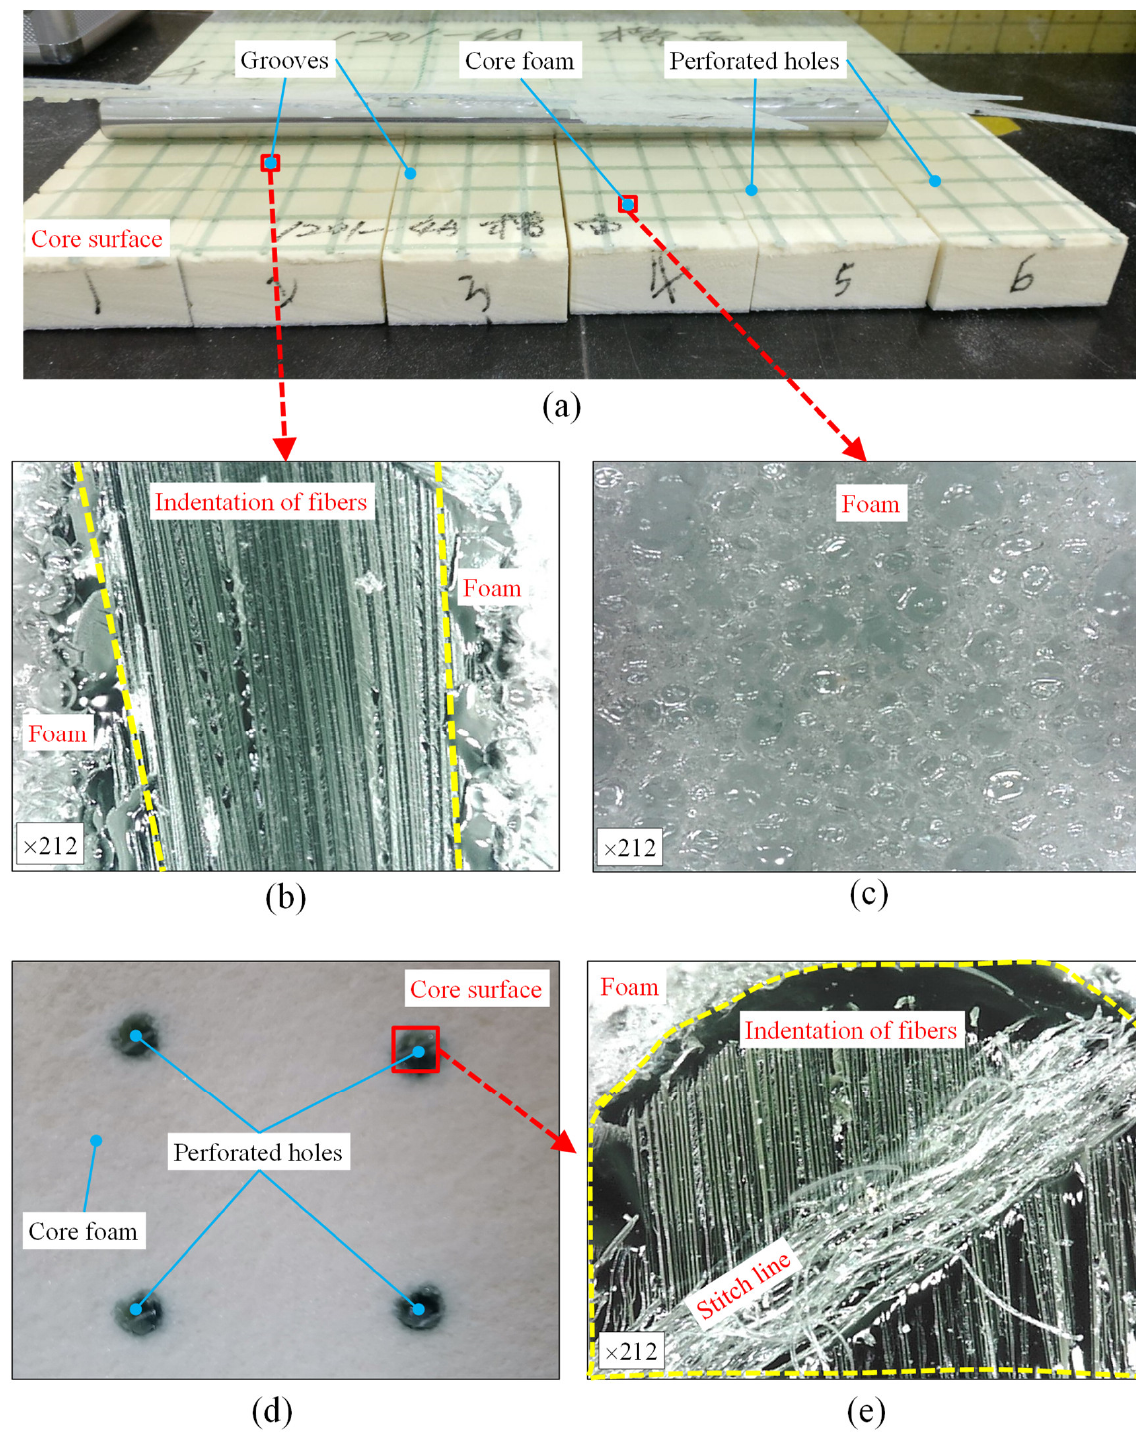
Figure 12. Typical fracture morphology of the peel specimens: ( a ) fracture surfaces of GP core specimens, ( b ) the micro-topography of grooves, ( c ) the micro-topography of foam, ( d ) the other fracture surface of the GP core specimen, and ( e ) the micro-topography of perforated hole.